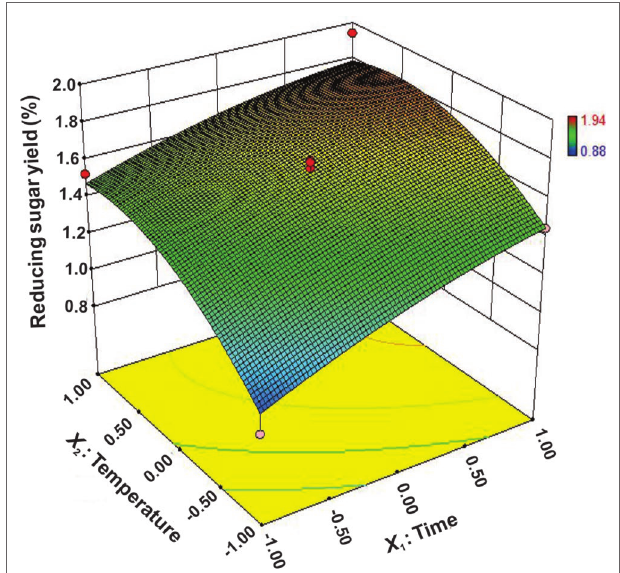
FIGURE 5 | Response surface plot of reducing sugar released by rice straw as a function of time and temperature.